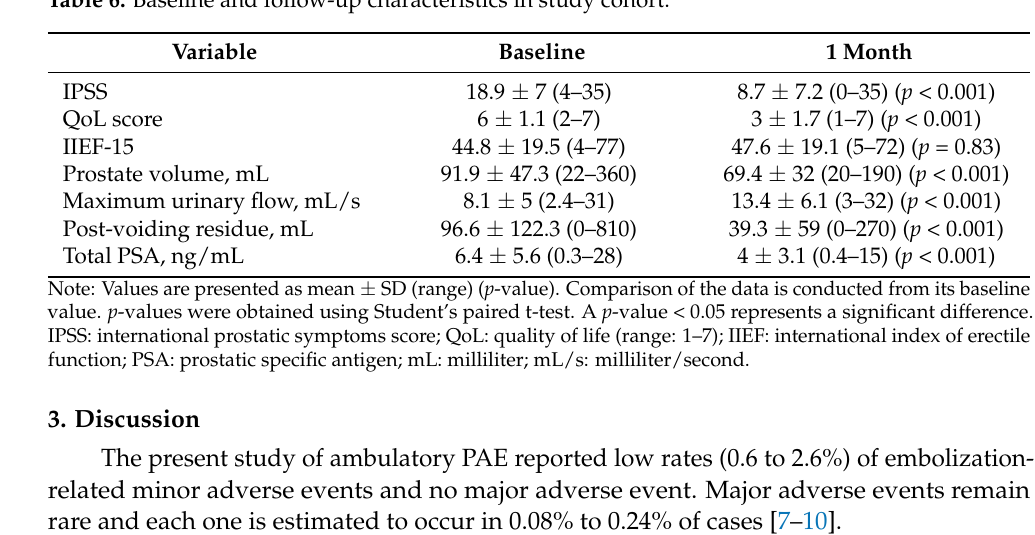
Table 6. Baseline and follow-up characteristics in study